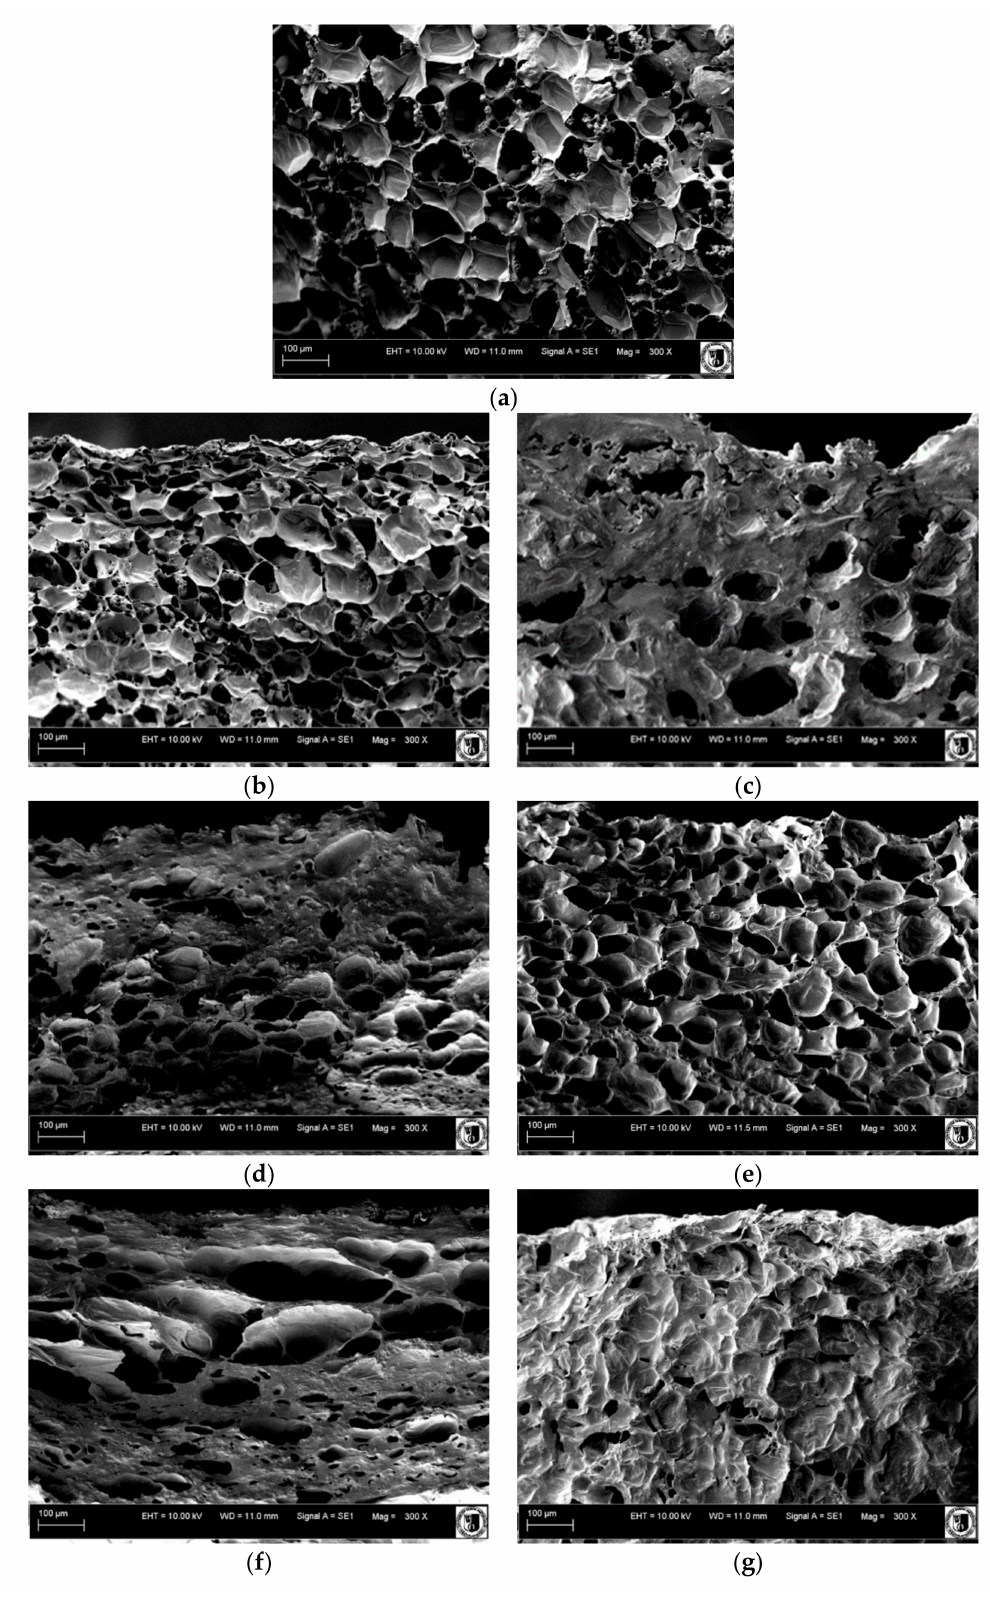
Figure 2. Scanning electron microscope (SEM) imaging of the pumpkin cylinders ( a ) before the OD, ( b ) after 15 min of OD in NF solution, ( c ) after 120 min of OD in NF solution, ( d ) after 15 min in OS 8 µ m, ( e ) after 120 min in OS 8 µ m, ( f ) after 15 min in OS 0.2 µ m, and ( g ) after 120 min in OS 0.2 µ